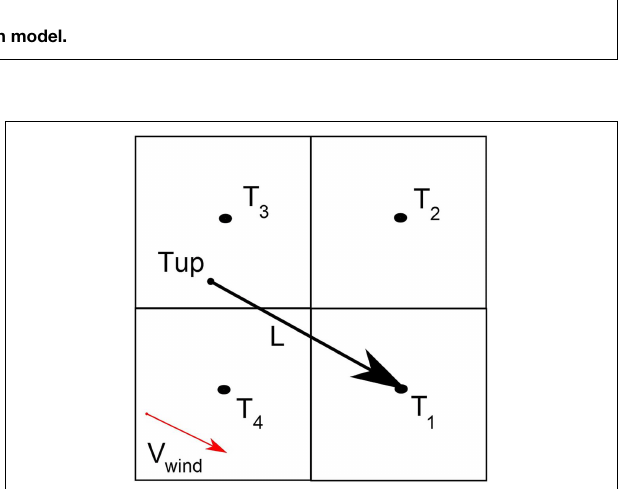
FIGURE 5 | Lagrangian advection model. The upstream temperature T u p is calculated with a bilinear interpolation of T 1 , T 2 , T 3 and T 4